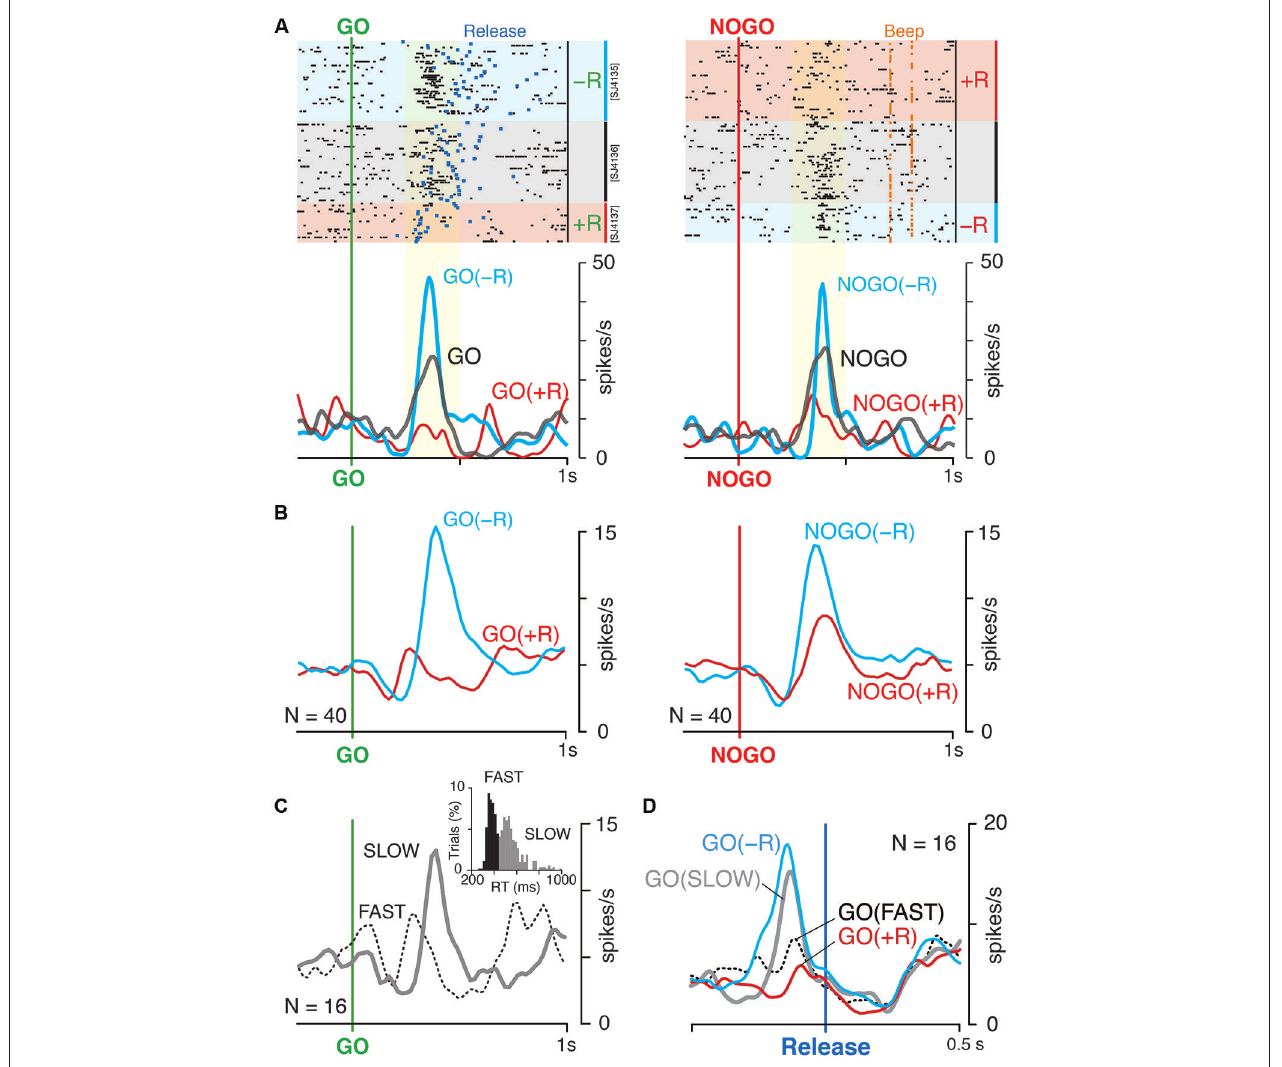
quantitative analysis in Figure 4A . (B) Population histograms (smoothed, SD = 20 ms) of 40 LLF neurons in biased blocks. Activities are separately plotted by reward condition ( + R, red; − R, blue). (C) Population histogram of 16 LLF neurons in even reward blocks. Activities are separately plotted by mode of RT as shown in inset (Fast, dotted curve; Slow, solid curve), in which bimodal distribution of RT in even-reward block are shown. Black and gray histograms assign the trials to fast (<440 ms) and slow mode (>440 ms), respectively. (D) Population histogram of 16 LLF neurons in even-reward blocks and that of the same neurons in GO-NOGO task. Colors assigned are the same as in B and C . All data shown were obtained from monkey